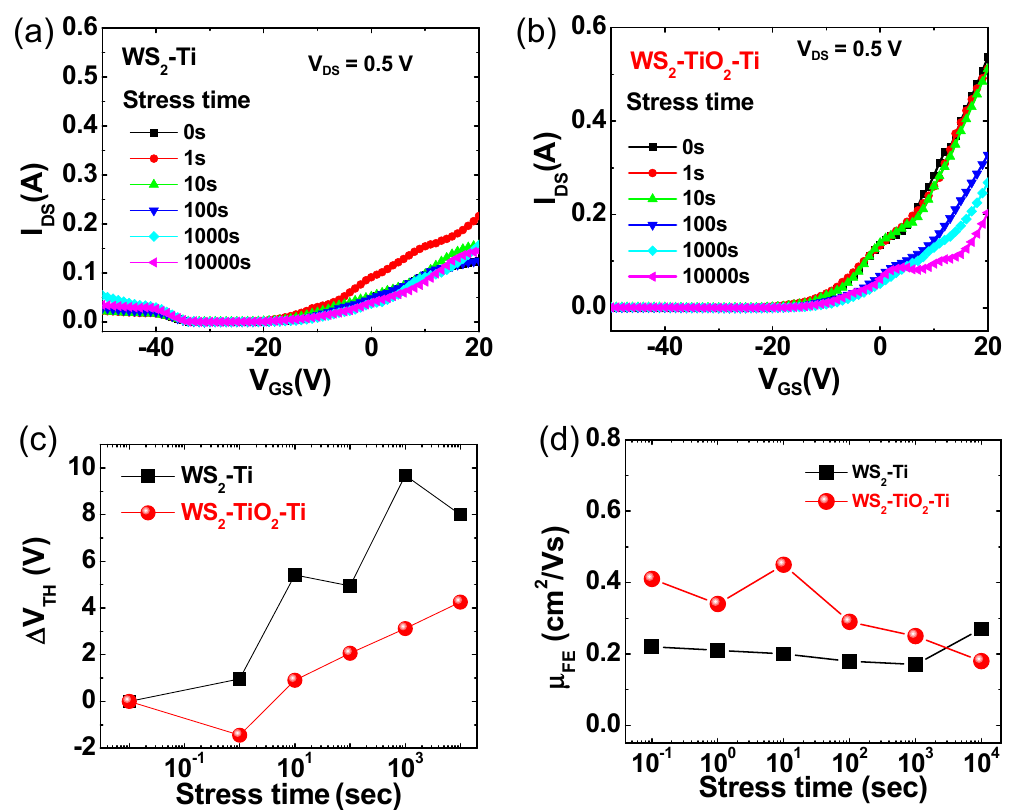
Figure 4. Transfer curves (I DS -V BG ) of WS 2 FETs ( a ) without TiO 2 and ( b ) with a TiO 2 layer during a 10,000 s gate-bias stress measurement at room temperature. The summary of ( c ) the ∆ V TH shift and ( d ) the μ FE change as a function of the stress time for WS 2 -Ti and WS 2 -TiO 2 -Ti devices.